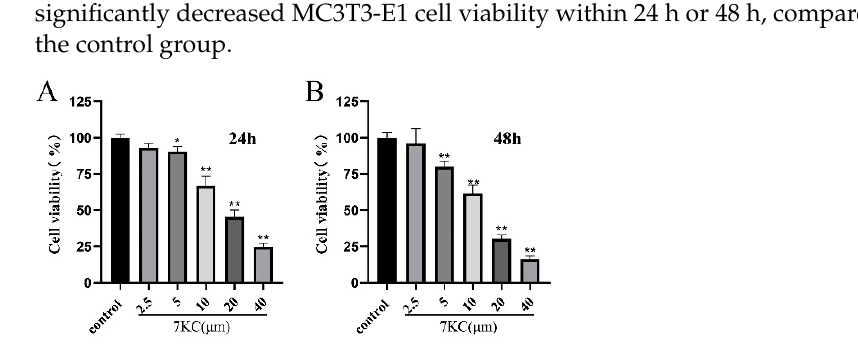
Figure 1. 7KC inhibited MC3T3-E1 cell viability. ( A , B ) MC3T3-E1 cells were treated with 7KC (0, 2.5, 5, 10, 20, or 40 μ M) for 24 h and 48 h. * p < 0.05; ** p < 0.01.